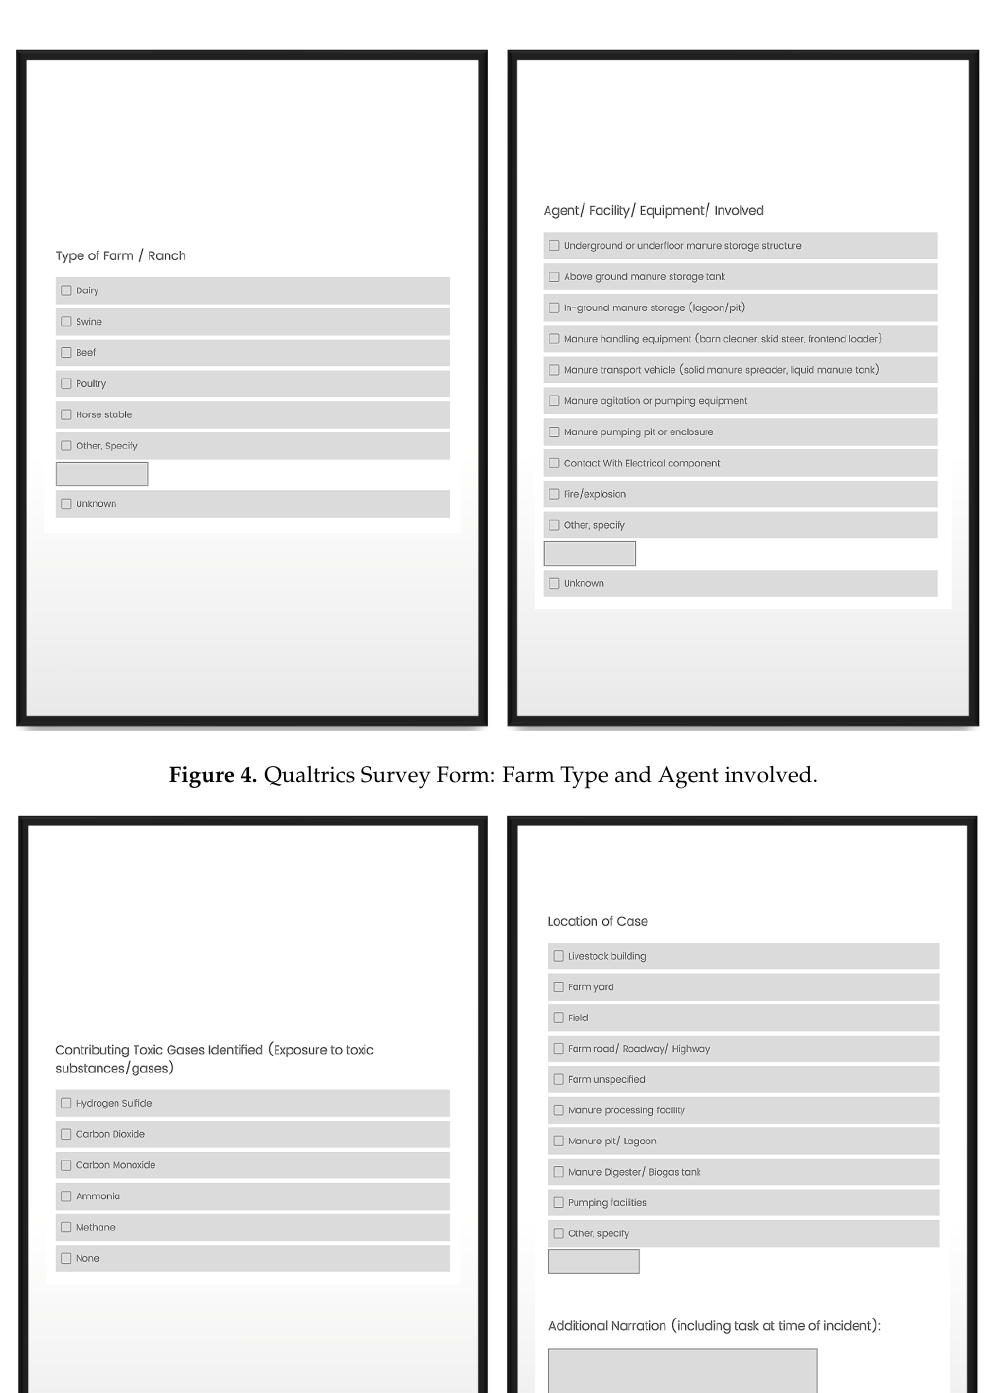
Figure 3. Qualtrics Survey Form: Date, Time, Day, Location, Victims, Class.